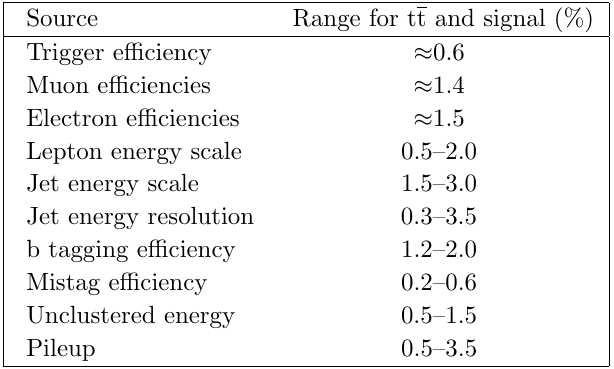
Table 2 . Summary of the uncertainties in tt background and signal simulation resulting from experimental uncertainties. The numbers represent typical values of the uncertainties in the signal and tt background yields or ranges for these uncertainties in di(cid:11)erent M T2 bins and in di(cid:11)erent signal